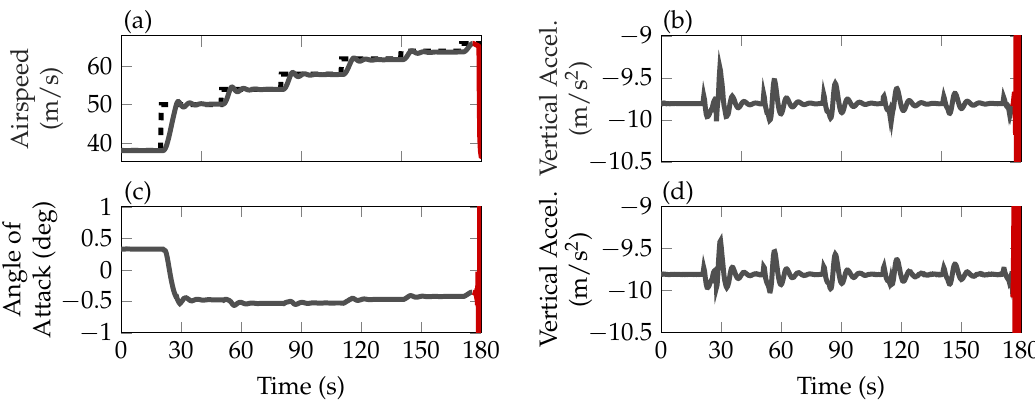
Figure 10. Simulation results with flutter suppression controller for an acceleration scenario for indicated airspeed ( a ), accelerations on the wing tip ( b ), angle of attack ( c ), and accelerations on the wing root ( d ). The flight in the stable regime is indicated in gray ( ), the unstable situation in ).